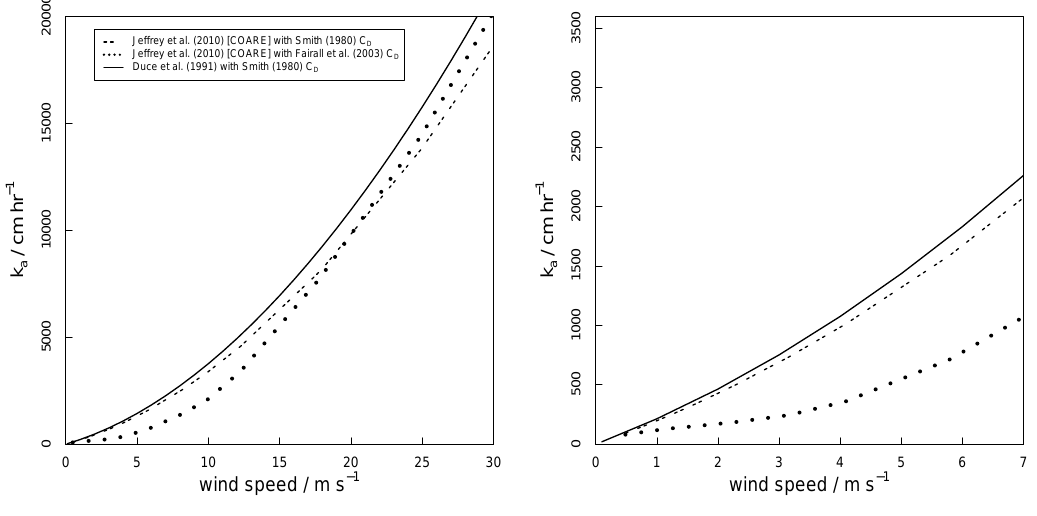
Fig. 4. Comparison of the k a scheme presented here with the modified COARE algorithm from Jeffery et al. (2010), demonstrating the sensitivity to the term used for the drag coefficient NOAA COARE drag coefficient data extracted from graph in Fairall et al.